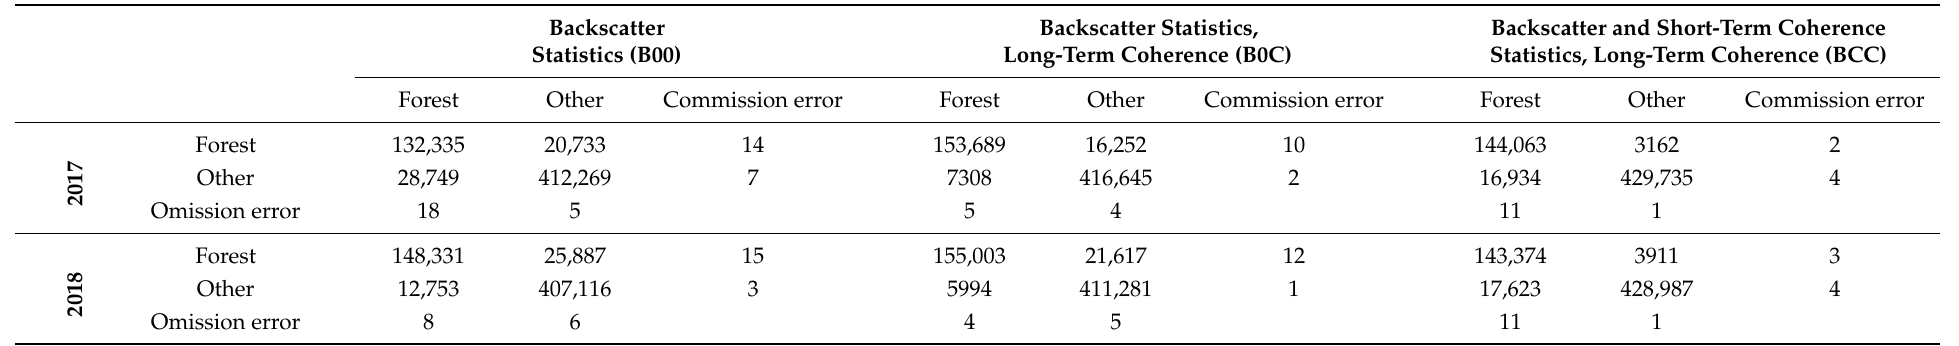
Table A2. Temperate site confusion matrices by year and feature set (Reference > columns; Classified > Rows) compared to the GEDI validation